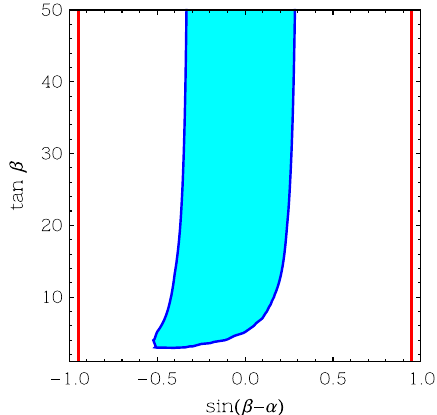
Fig. 2 The alignment limit in the 2HDM (shown in red) and in this model (shown as the shaded region within the blue contour). As can be seen, while the 2HDM alignment limit is forced near the sin (β − α) ≈ ± 1 regions, the corresponding limit for this model occurs in the region − 0 . 5 ≤ sin (β − α) < 0 . 3 owing to the nature of the g hWW